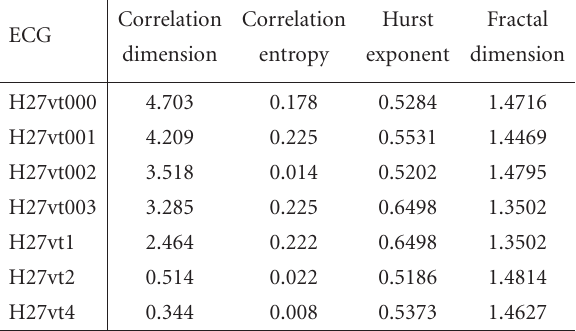
Table 4.1. Reduction of the main nonlinear dynamic characteristics on the presence of arrhythmia.